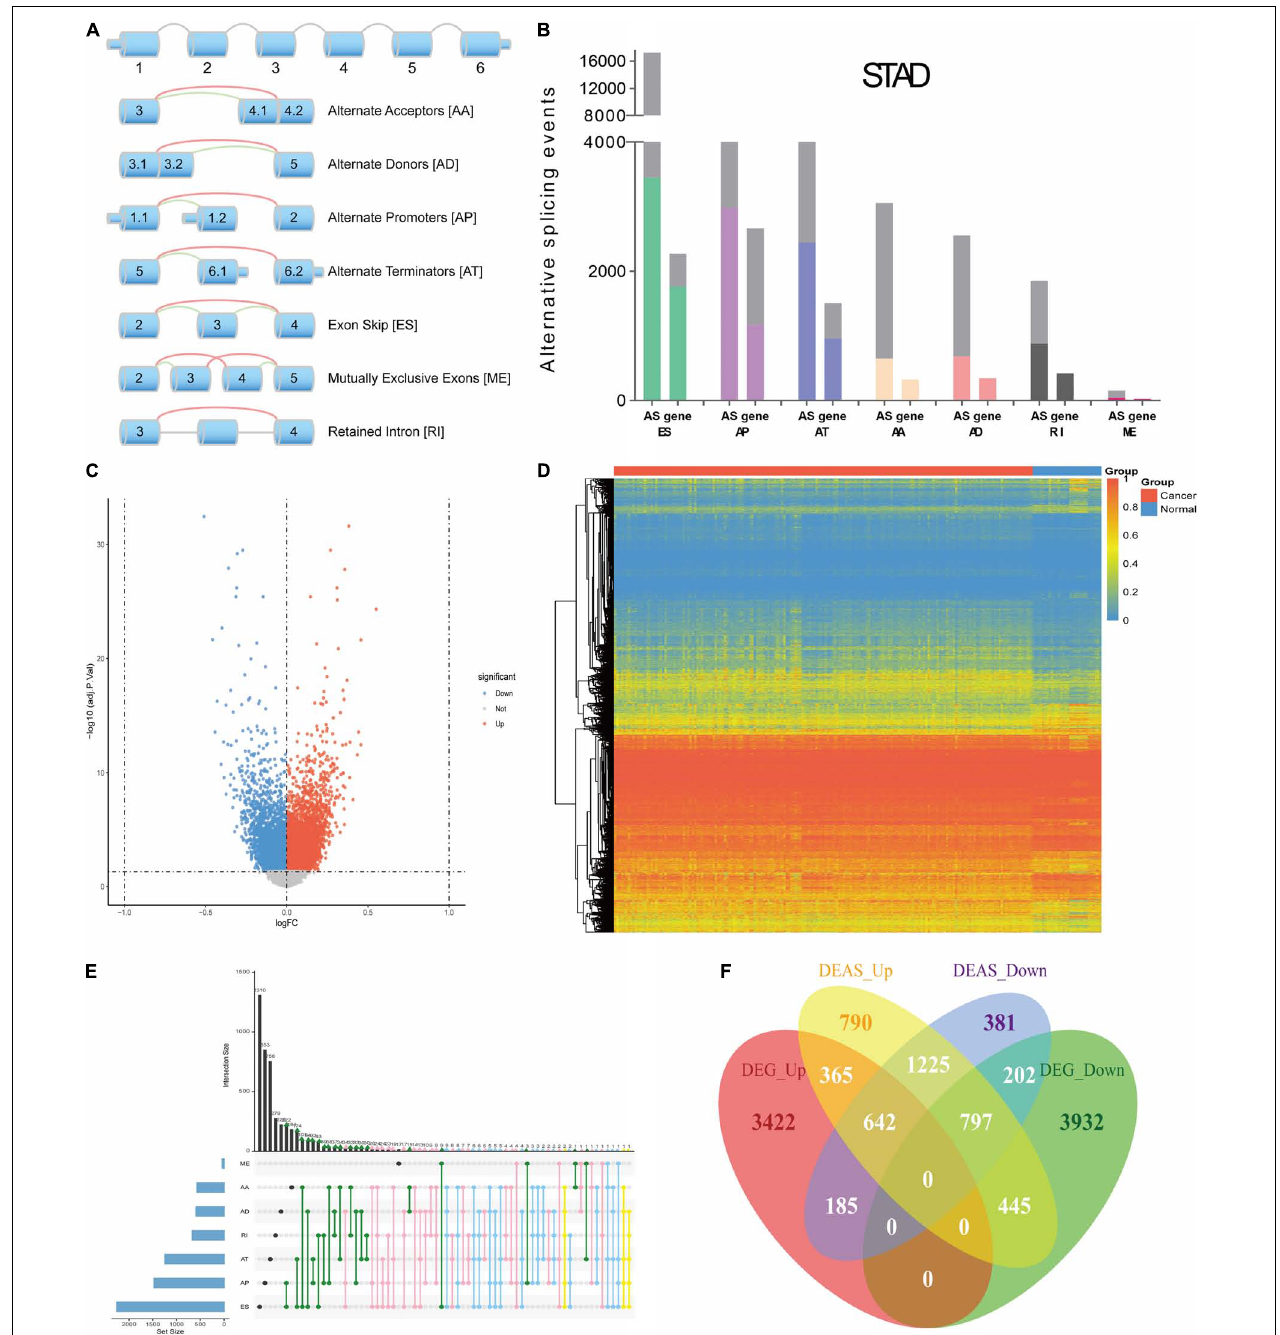
FIGURE 2 | Overview of AS events profiling in GC. (A) Illustration of the splicing patterns of seven types of AS events, including alternate acceptor site (AA), alternate donor site (AD), alternate promoter (AP), alternate terminator (AT), exon skip (ES), mutually exclusive exons (ME) and retained intron (RI). (B) Seven types of AS events and corresponding genes from the patients in training group are depicted according to a classified P -value of 0.05. (C) The difference in AS events between GC tissues and normal tissues. The DEAS identified in GC was visualized in a Volcano plot. The red and blue points in the plot represent DEAS with statistical significance (adj P value < 0.05). (D) Heat map of the DEAS. The horizontal axis shows clustering information of samples divided into two major clusters: GC tissue and normal tissue. The left longitudinal axis showed the DEAS clustering information. The gradual change of color from green to red represents the alteration in DEAS expression from low to high. (E) UpSet plot of the interactions between DEAS events and their parent genes. (F) Venn diagram demonstrated the intersection set of DEAS and DEG.